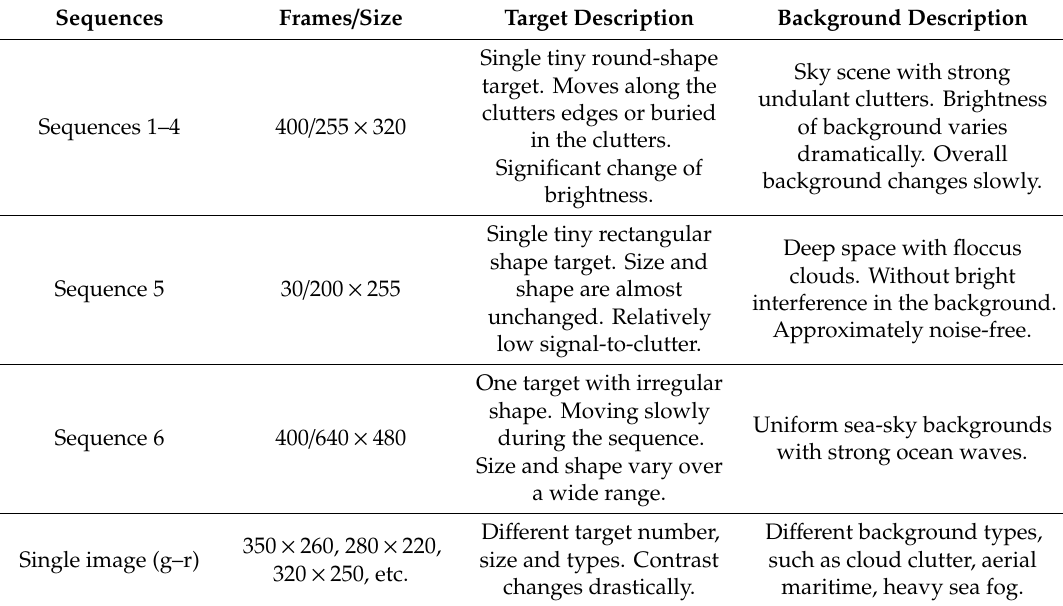
Table 1. Details of all testing infrared